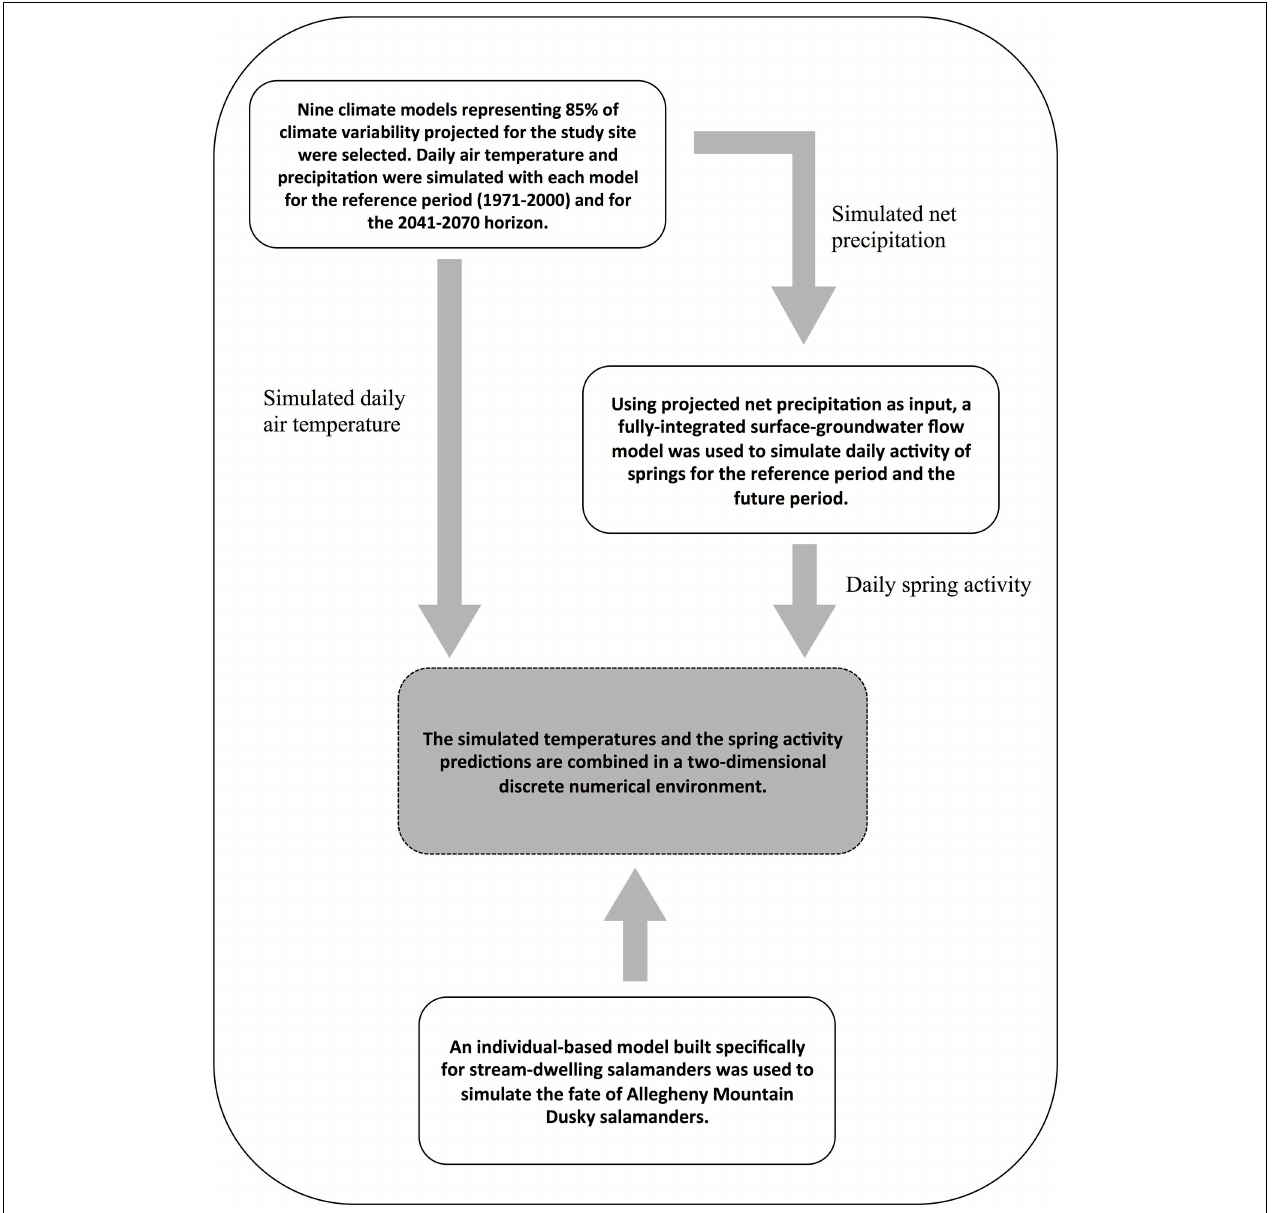
FIGURE 2 | Overview of the methodology used to predict the viability of stream salamanders in a changing